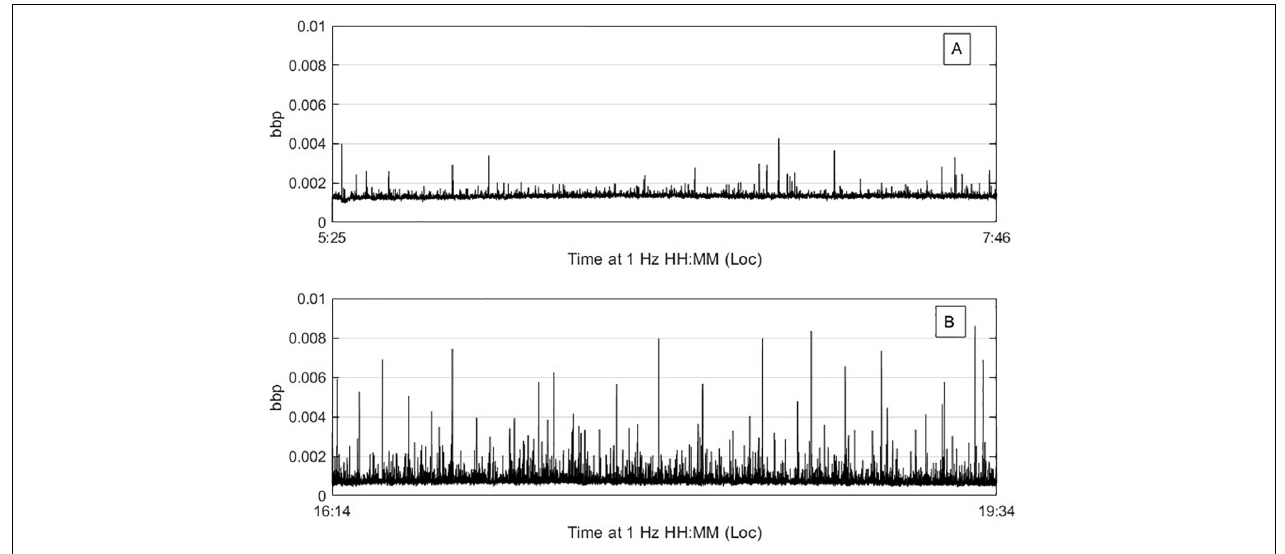
FIGURE 9 | Particle backscatter time series from the ECO-VSF for dusk (A) and dawn (B) .